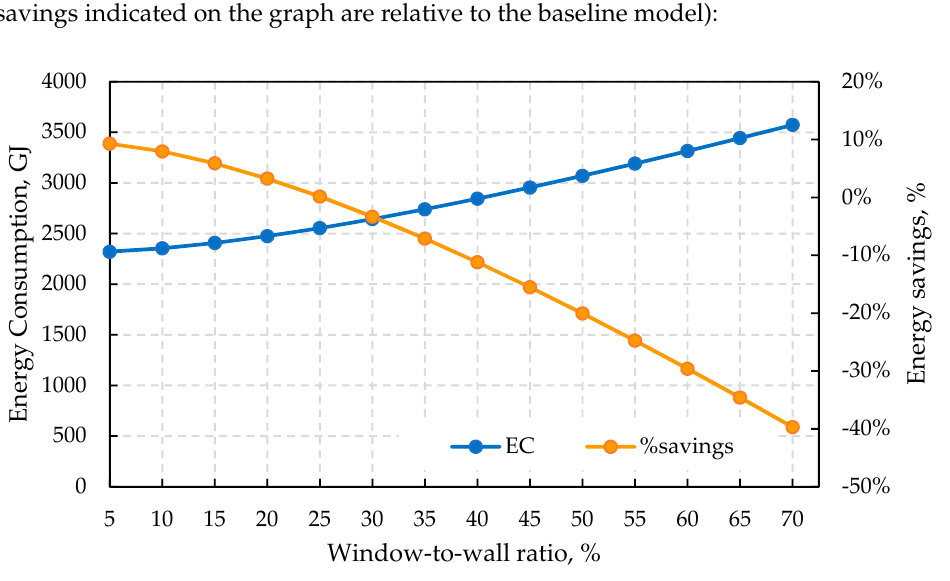
Figure 4. Effect of window-to-wall ratio on building energy consumption.